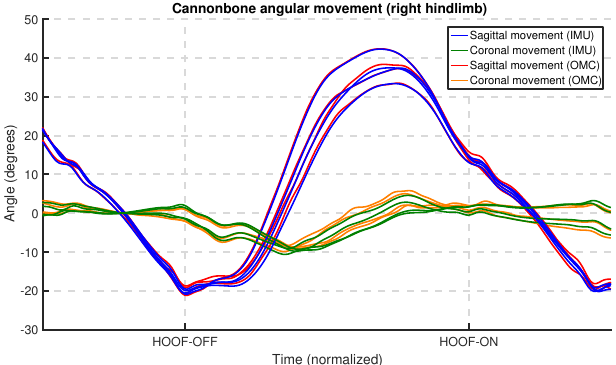
Figure 14. Example of the cannon bone angular motion for IMU and OMC